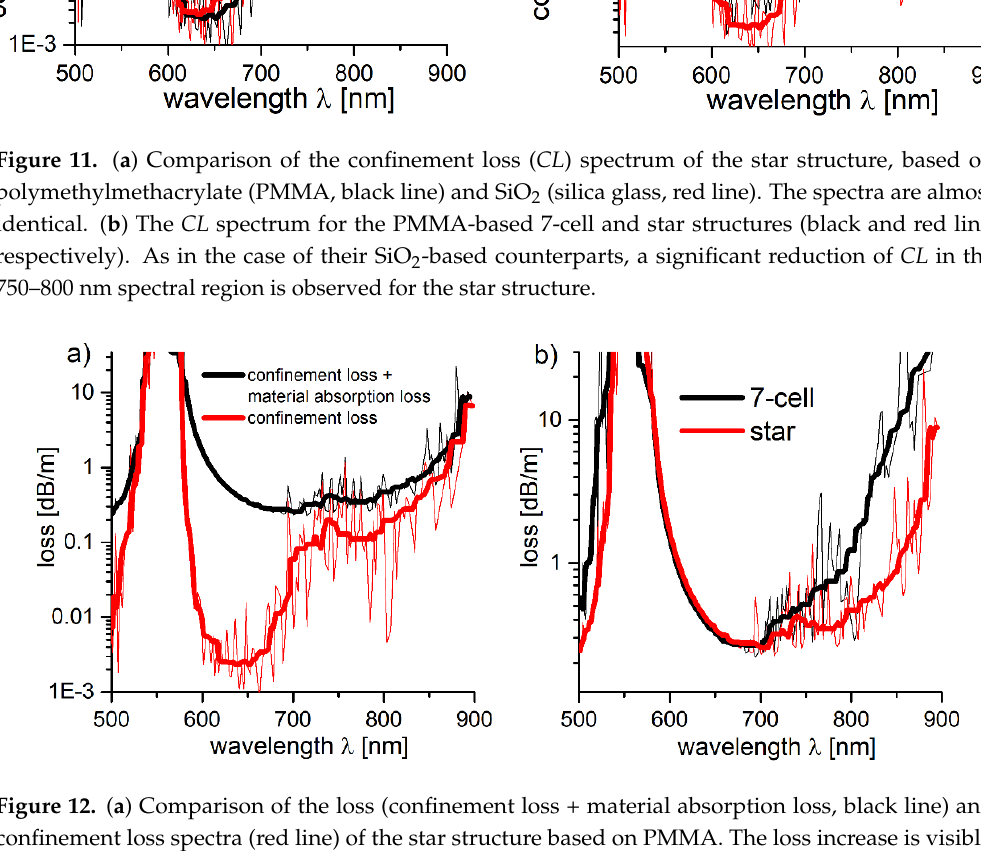
Figure 11. ( a ) Comparison of the confinement loss ( CL ) spectrum of the star structure, based on polymethylmethacrylate (PMMA, black line) and SiO 2 (silica glass, red line). The spectra are almost identical. ( b ) The CL spectrum for the PMMA-based 7-cell and star structures (black and red line, respectively). As in the case of their SiO 2 -based counterparts, a significant reduction of CL in the 750– 800 nm spectral region is observed for the star structure.